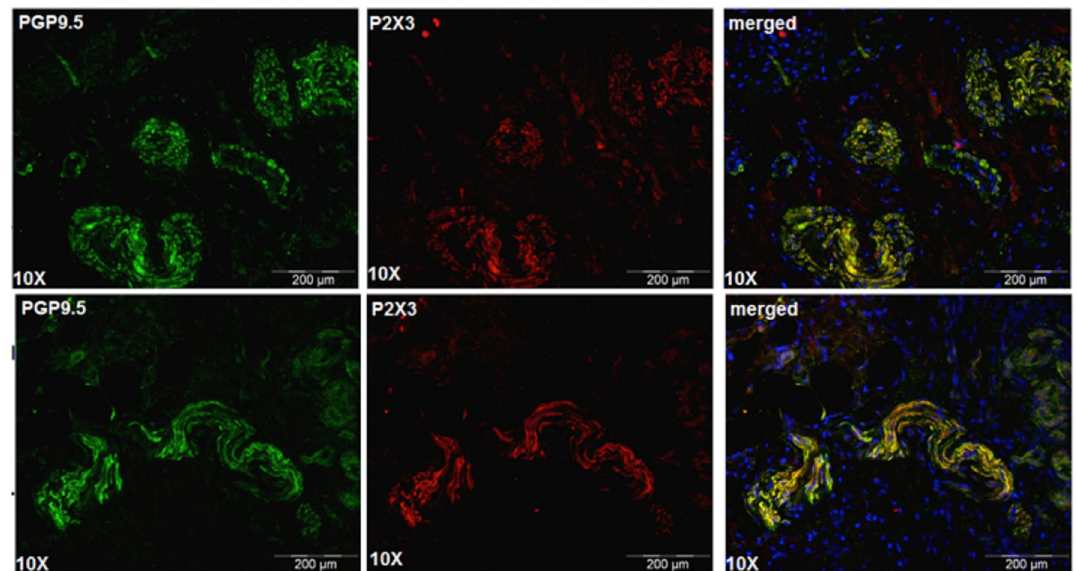
Figure 4. P2X3 is expressed on nerve fibers in human endometriotic lesions. Endometrial tissue samples were stained with antibodies for P2X3 and for the neuroendocrine marker, PGP9.5. Nerve fibers are stained green using PGP9.5 as a marker protein. P2X3 is stained red. The merged image shows the overlay of the two fluorescence signals showing P2X3 receptor expression (red) and the expression of PGP9.5 (green) which overlap spatially in the nerve fibers (yellow). Immunofluorescence images were obtained under a tenfold